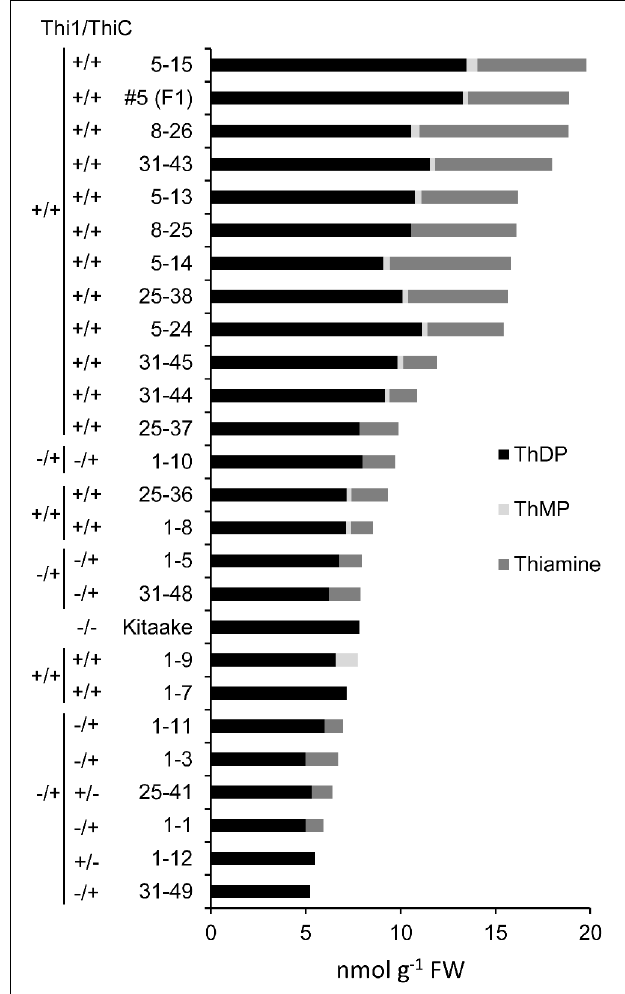
FIGURE 5 | Thiamin, ThMP, and ThDP concentrations in leaves of F 2 progeny from crosses between THI1 and THIC lines. T 2 progenies from lines THI1-7-31 and THIC-1-30 were used in reciprocal crosses to generate THI1 × THIC overexpressing lines. These lines were used because their flowering times coincided. F 2 progenies from F 1 lines 1, 5, 8, 25, and 31 were used for analysis. Each F 2 individual plant was tested for the presence ( + ) or absence (–) of the THI1 and THIC transgenes as indicated and also shown in Supplementary Figure 1F. #5 (F1) is the F 1 parent of F 2 progenies 5–13, 5–14, 5–15, and 5–24 and was included in the analyses. Data are means of two determinations.